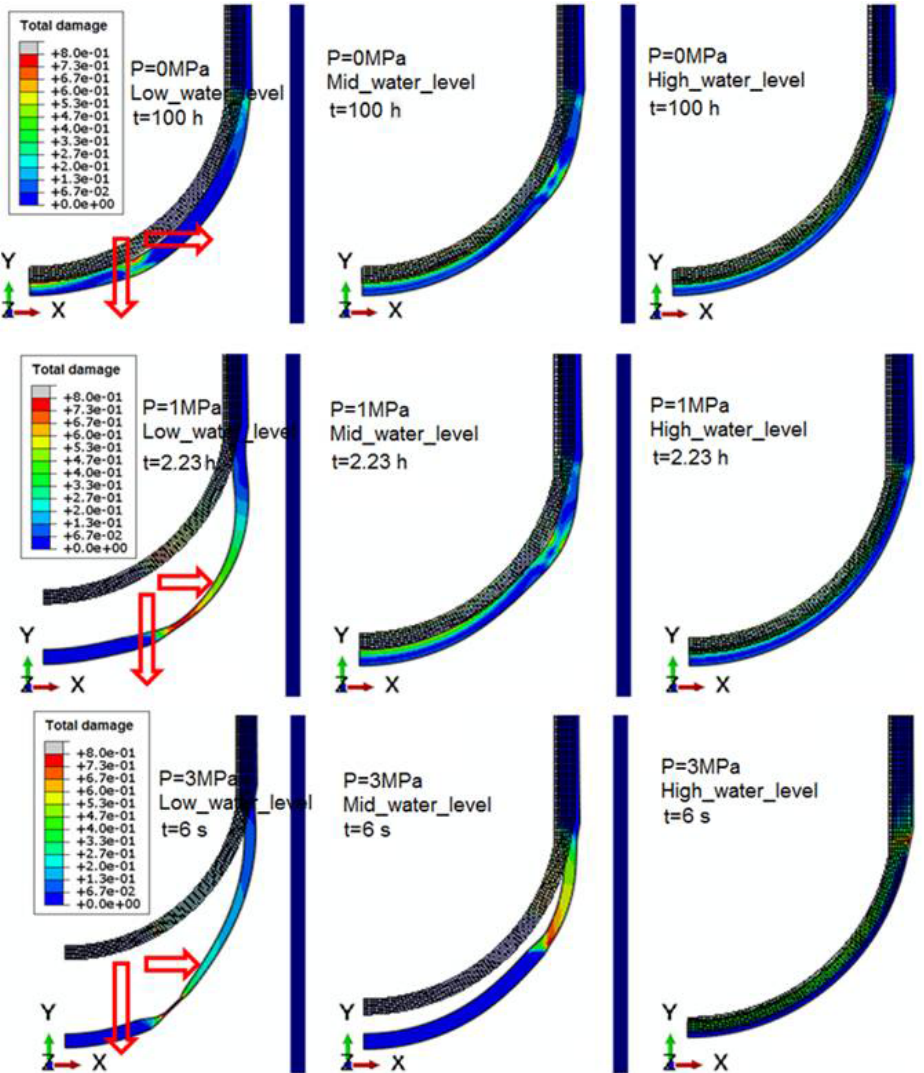
Figure 17. Comparison of damage contours for RPV with various water levels and internal